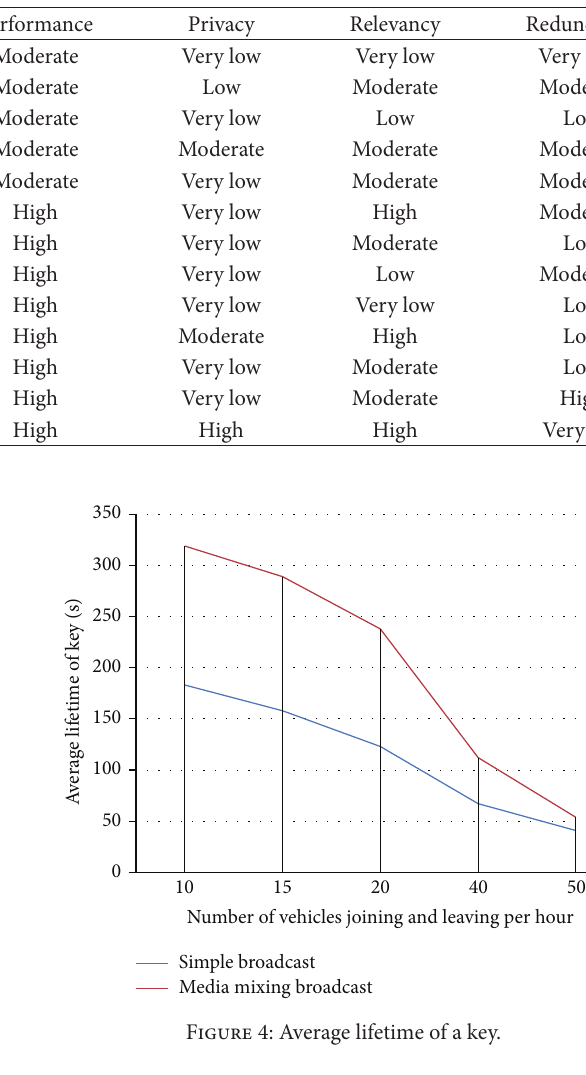
Table 7: Comparison of media mixing algorithms with existing broadcast approaches.